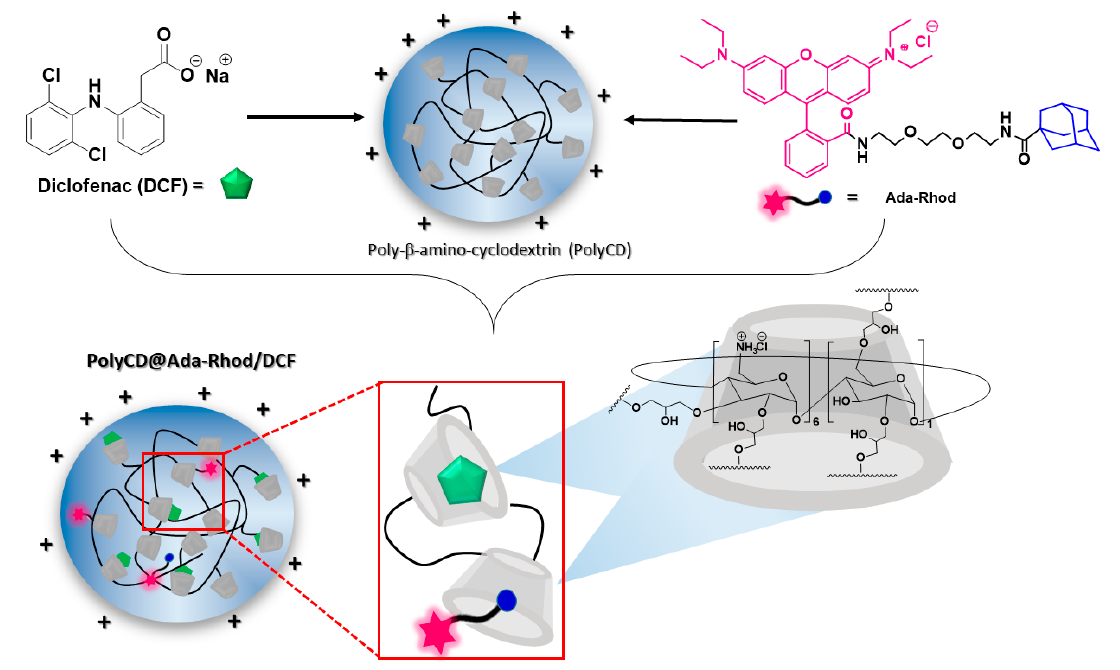
Table 1. Overall properties of PolyCD-based nanoassemblies: mean D H , polidispersity index (PDI) and ζ -potential values ( ζ ), loading and EE% in ultrapure